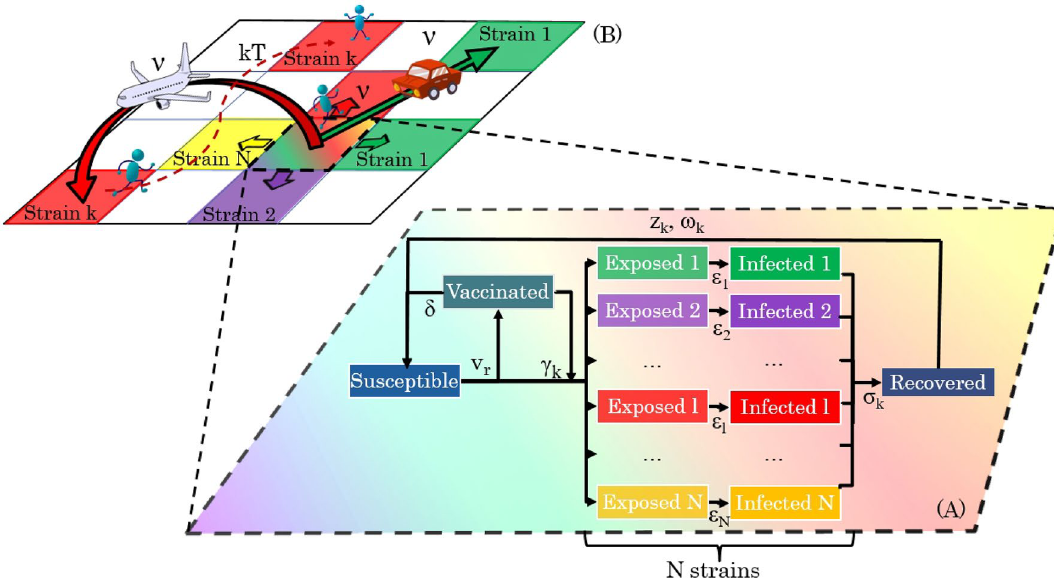
Figure 1. Diagram showing the geo-stochastic model scheme. ( A ) Represents the local dynamics of a SEIRS-V model. The compartments taken into account are: Susceptible, Recovered, Vaccinated, Exposed and Infected with different strains Vaccinated people can get infected with a certain variant k with a probability γ k . The exposed, infectious and immune periods for the k th strain are ǫ k , σ k and ω k , respectively. The variables v r and δ stand for the vaccination rate and the immunity period conferred by the vaccine. ( B ) The global dynamics on a geographical area, divided into a grid of cells, is followed by placing a SEIRS-V model on each one and